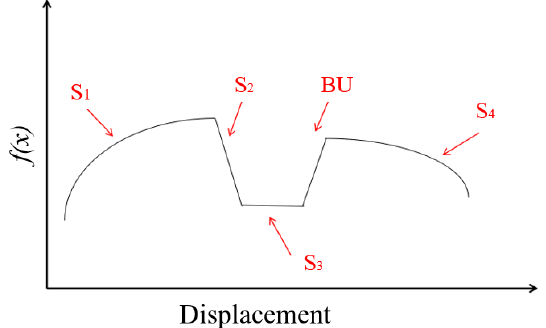
Figure 4. Five different behaviors of sentry function (SF) vs. displacement.